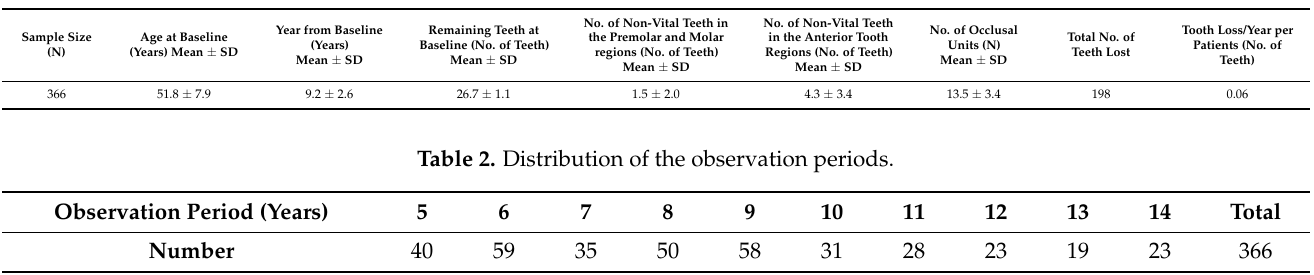
Table 1. Characteristics of patients in this study.